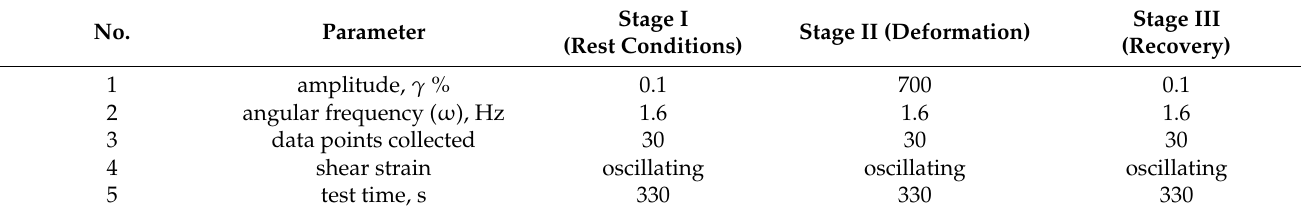
Table 4. The thixotropic test